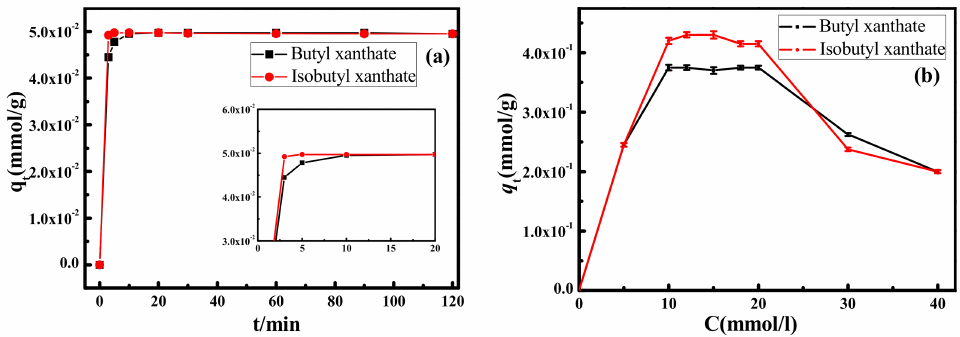
Figure 2. Adsorption kinetics ( a ) and isotherms ( b ) of xanthates on pyrite